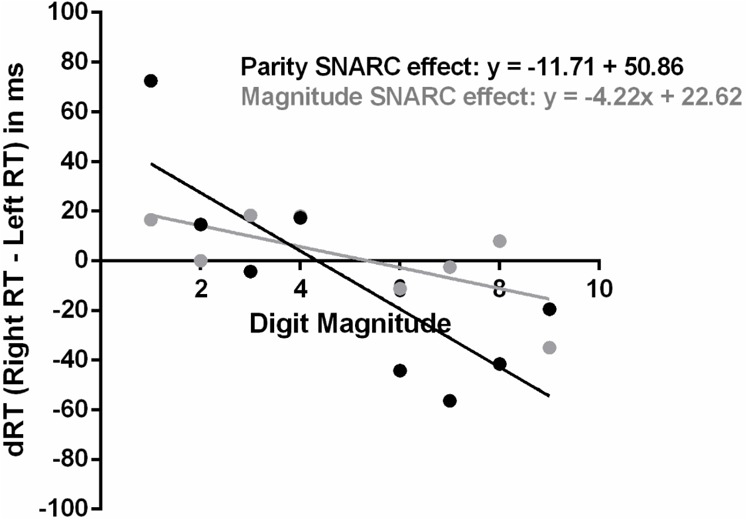
Regressions of number magnitudes onto dRTs (i.e., differences between right and left RTs) in the parity judgment and magnitude classification tasks.